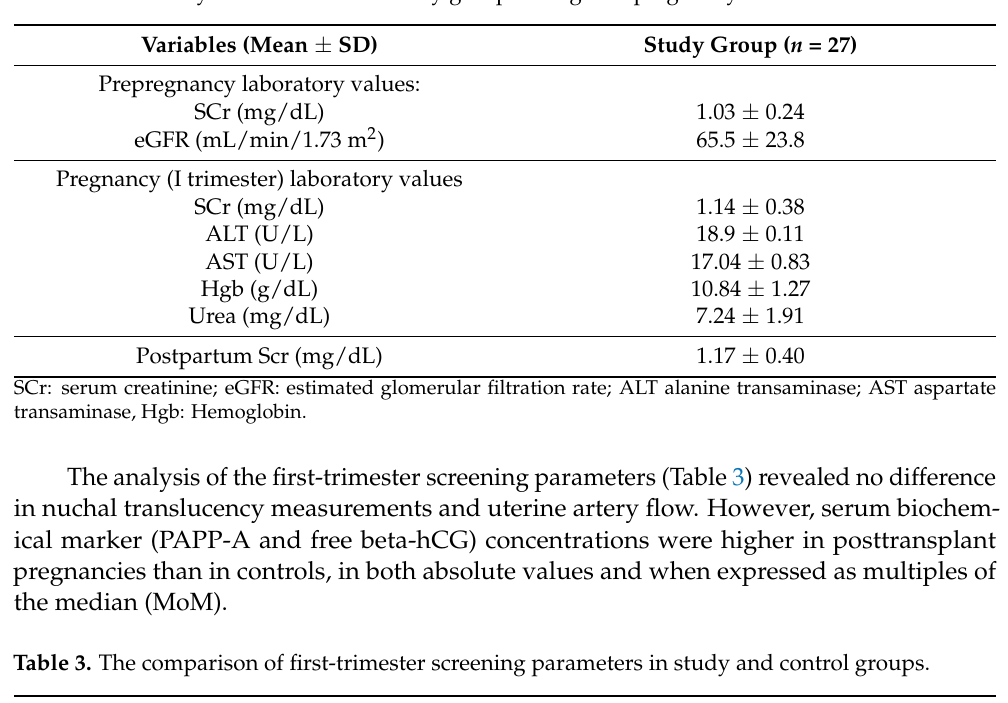
Table 2. Laboratory evaluation of the study group throughout pregnancy.